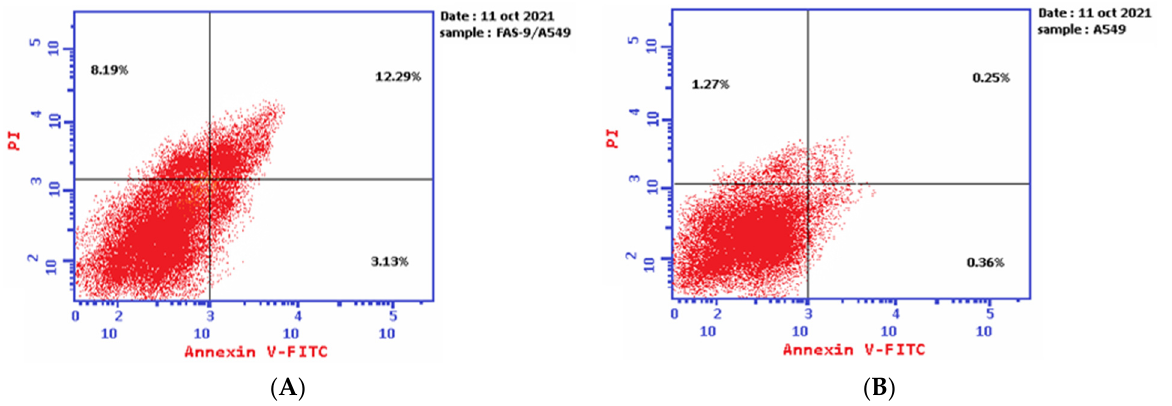
Figure 3. Demonstrated effect of P. tomentosa L. latex (IC 50 = 3.8 ug/mL) ( A ) on the percentage of Annexin V-FITC-positive staining monolayer A-549 cells versus the control ( B ) using flow cytometry.